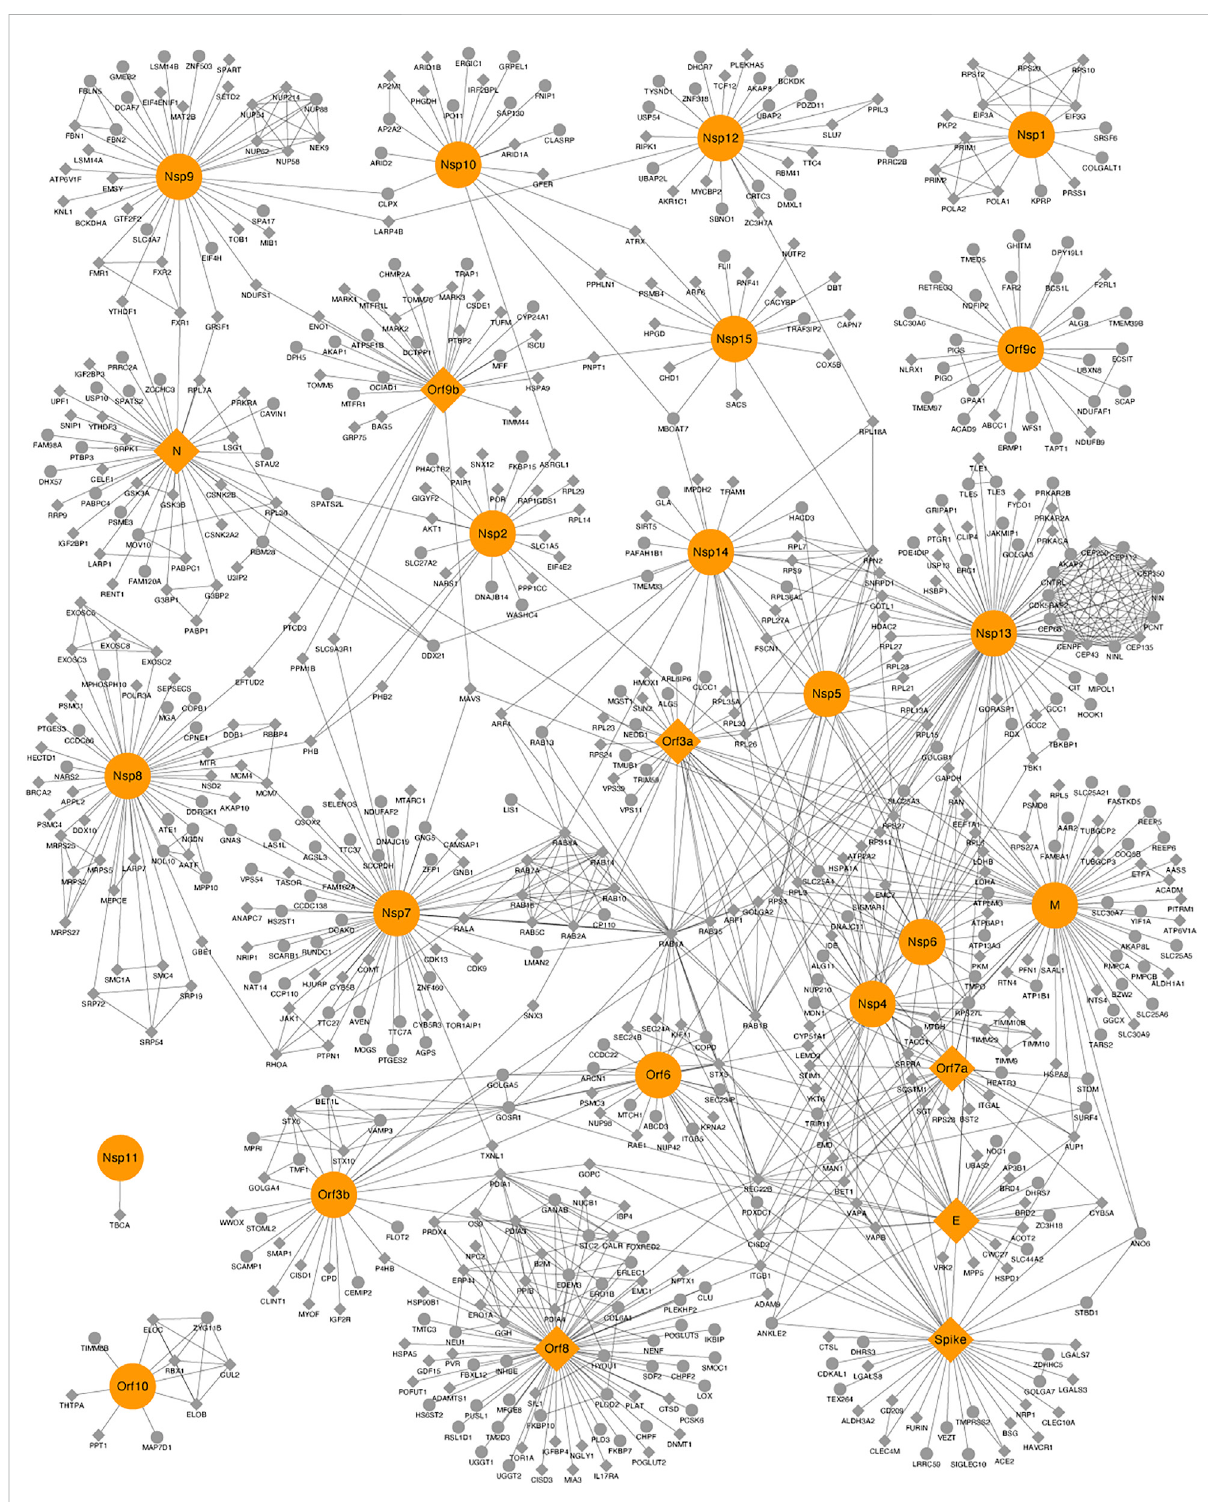
FIGURE 1 Protein – protein interaction (PPI) network between human – severe acute respiratory syndrome coronavirus 2 proteins. Viral and human